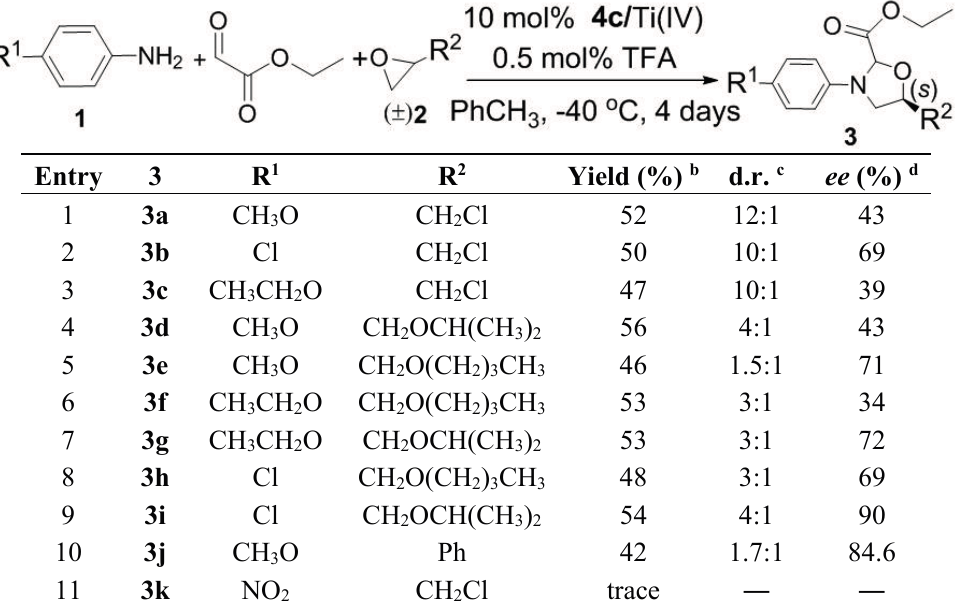
Table 2. Three-component reaction of anilines, ethyl glyoxalate, and epoxides a .